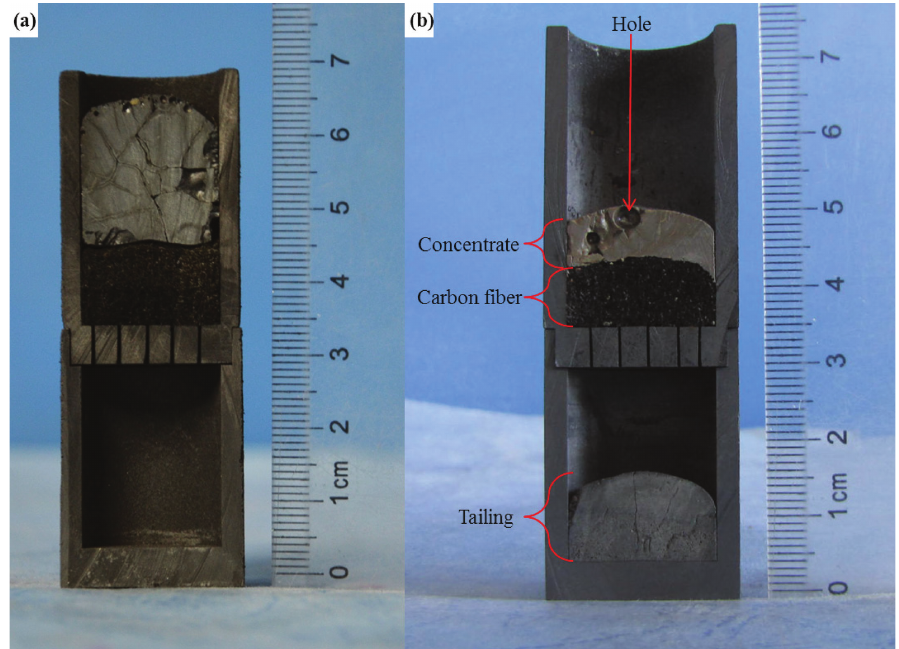
Fig. 5: Cross-section of the samples obtained by centrifugal separation compared with the parallel sample: (a) G = 1, t = 5 min, T = 1423 K; (b) G = 500, t = 5 min, T = 1423 K